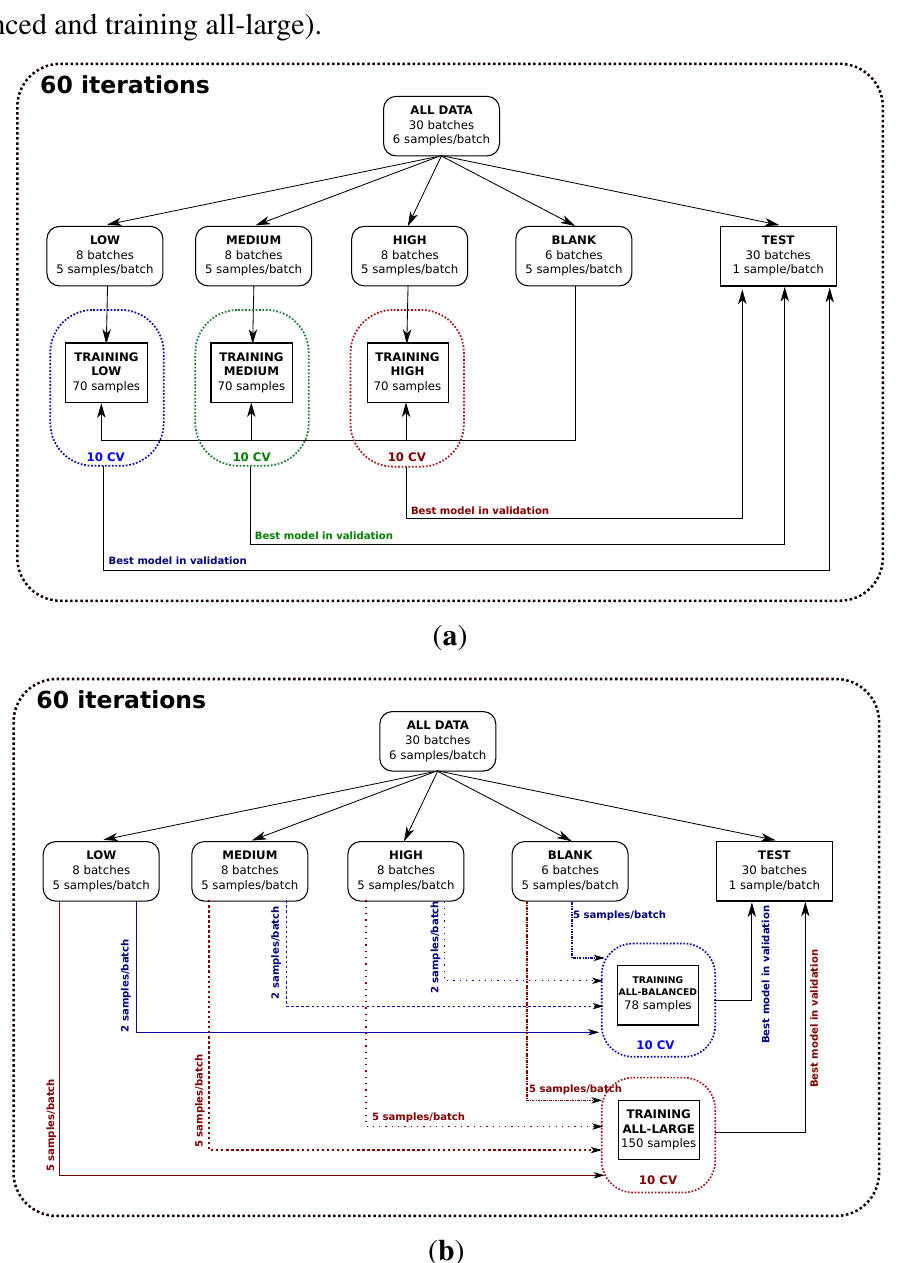
Figure 5. Distribution of the data in training and test datasets for ( a ) low/medium/high classifiers and ( b ) classifiers trained with samples at all of the concentration levels (training all-balanced and training